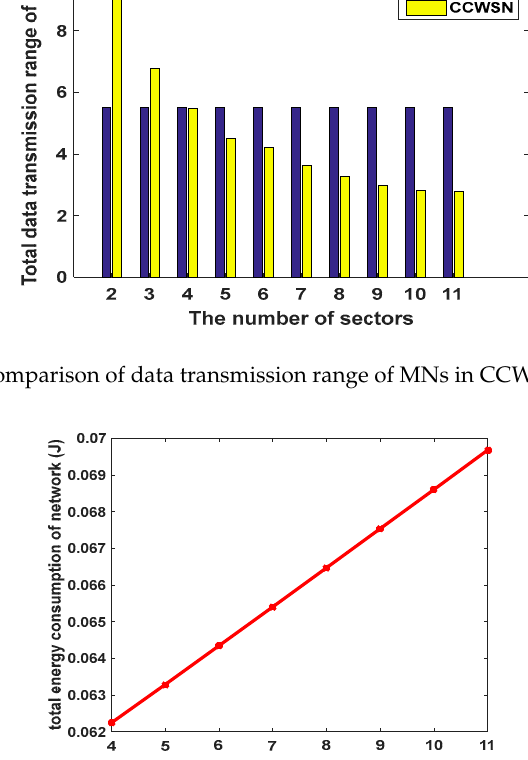
Figure 6. Total energy consumption of network in one round.